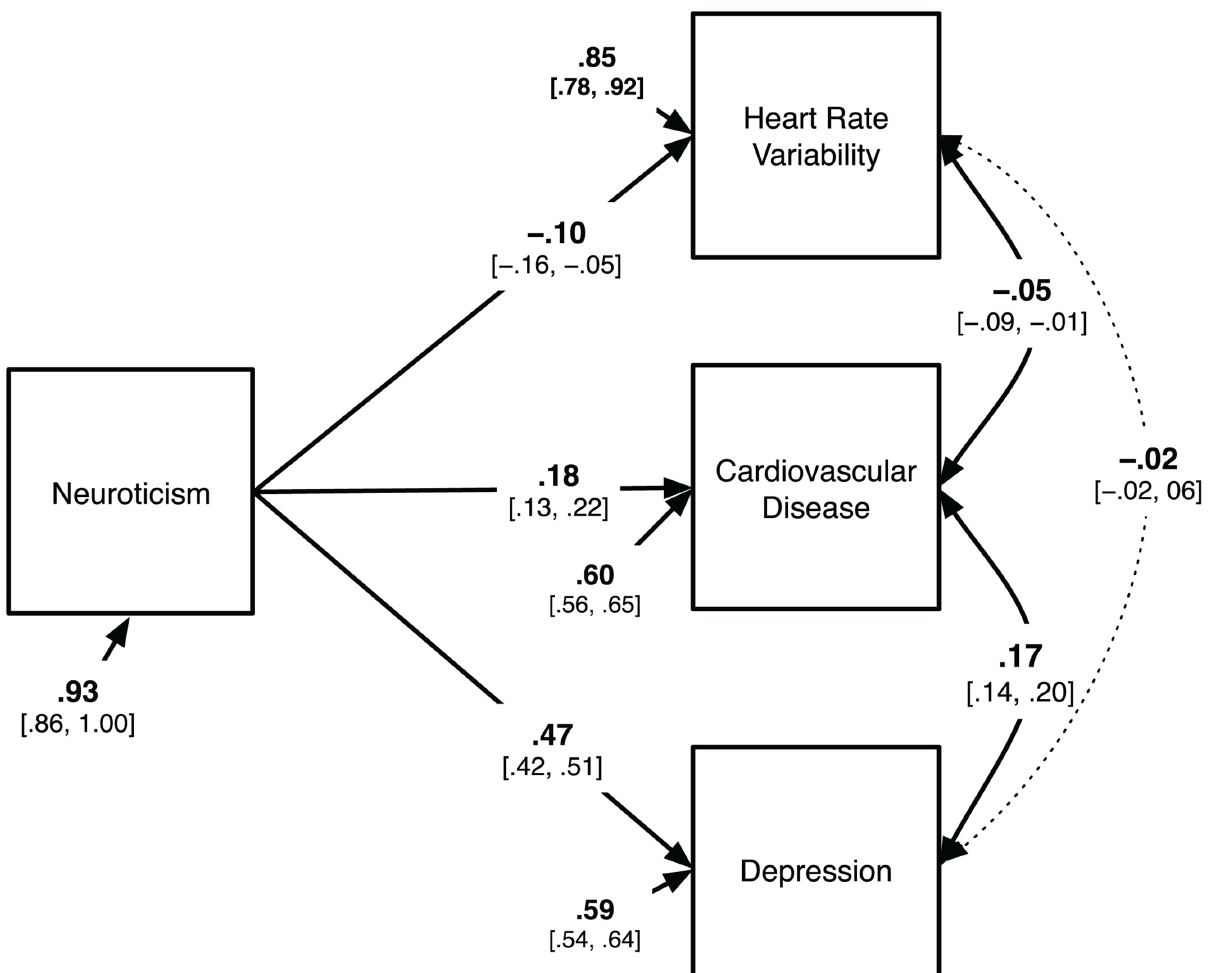
Fig 1. Structural model of the relationship of neuroticism with HRV, cardiovascular disease, and depression. Dotted paths are non-significant (95% CIs in brackets). Note. Covariates (age, sex, height, weight, BMI) are omitted for clarity. See S1 Table for the full list of path estimates.